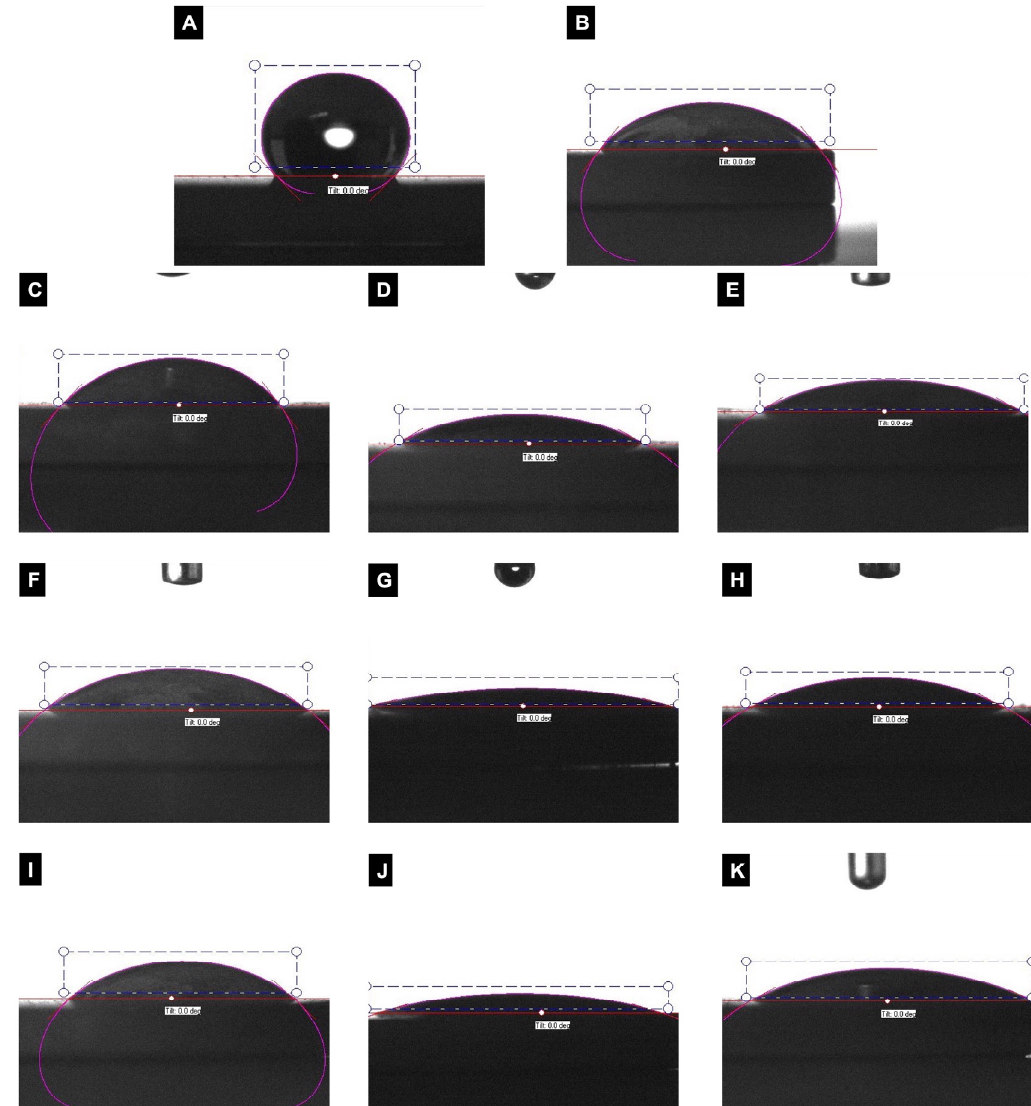
Figure 3. Representative images of contact angle measurement for various treated implant surfaces: ( A ) Negative-dry control group, ( B ) Positive-wet control group, ( C ) Laser, ( D ) Laser + H 2 O 2, ( E ) Laser + CHX, (F) Ti brush, ( G ) Ti brush + H 2 O 2 , ( H ) Ti brush + CHX, ( I ) Ti curette, ( J ) Ti curette + H 2 O 2 and ( K ) Ti curette + CHX.